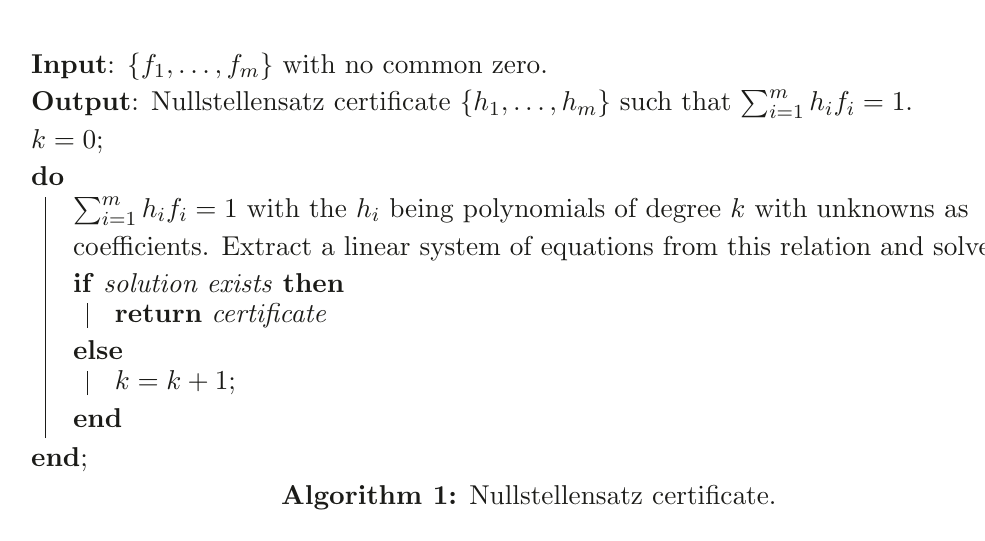
Algorithm 1: Nullstellensatz